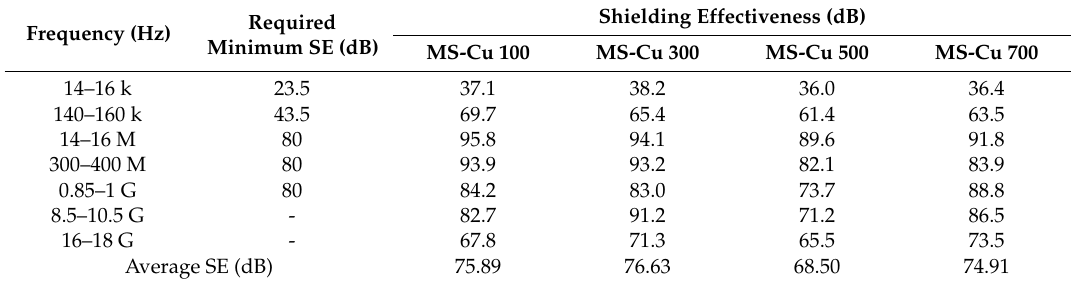
Table 5. SE test results of specimens 8–11.